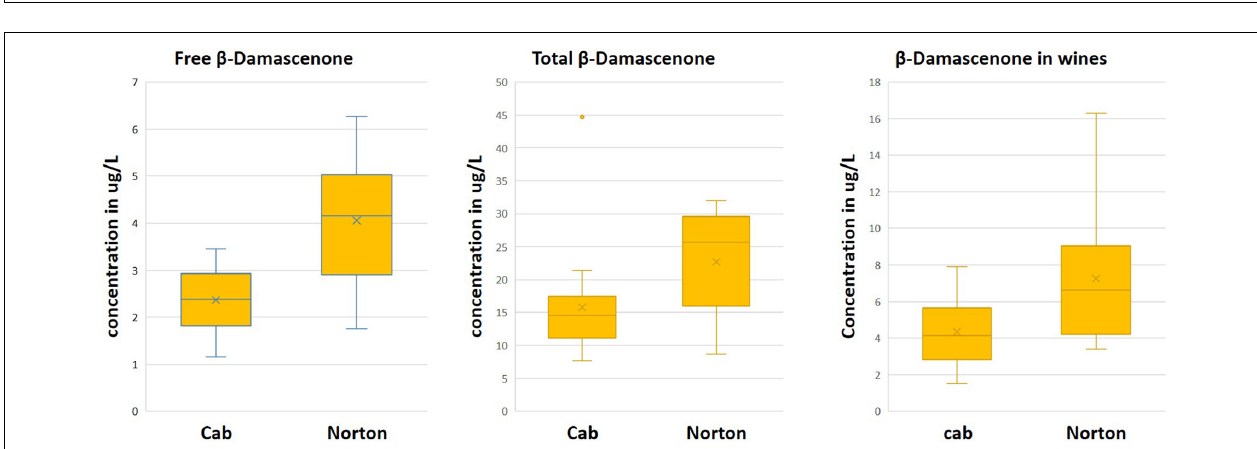
FIGURE 6 | Boxplot showing the distribution of β -damascenone in Norton and Cabernet Sauvignon (Cab) (A) free, (B) , total, and (C) wine volatiles. The y -axis denotes concentration in µ